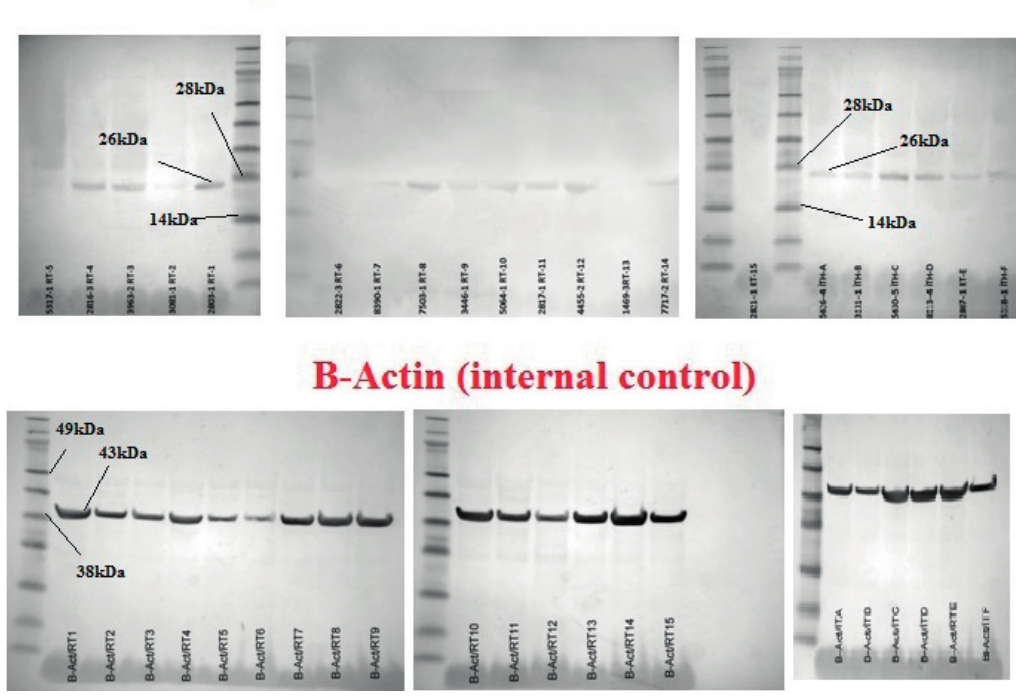
Fig. 4. Immunodetection of GSTA1, B-actin in recurrent tonsillitis and idiopathic tonsillar hypertrophy cyto- solic fractions (∼50 μg